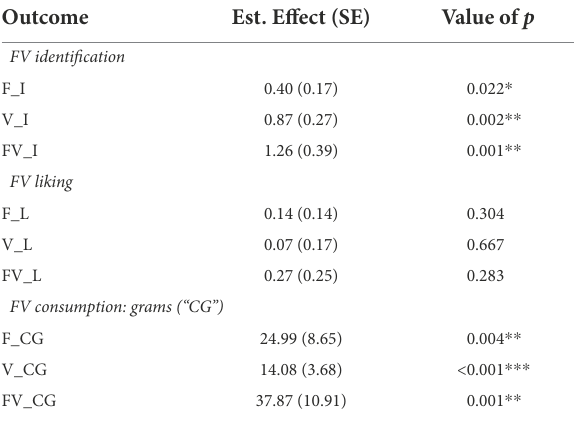
TABLE 4 Estimated intervention effect (standard error) for each outcome variable from a hierarchical linear mixed effect model, with assumption that year 1 and year 2 effects are the same.